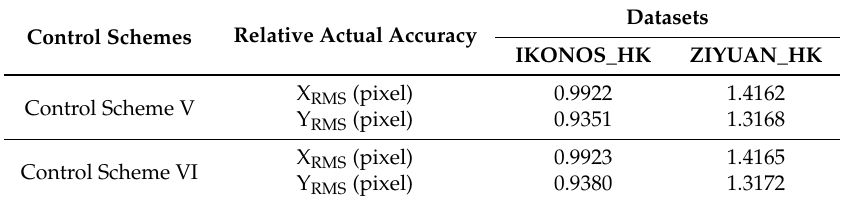
Table 4. Relative actual accuracies of Control Schemes V and VI by rigorous LBTM.